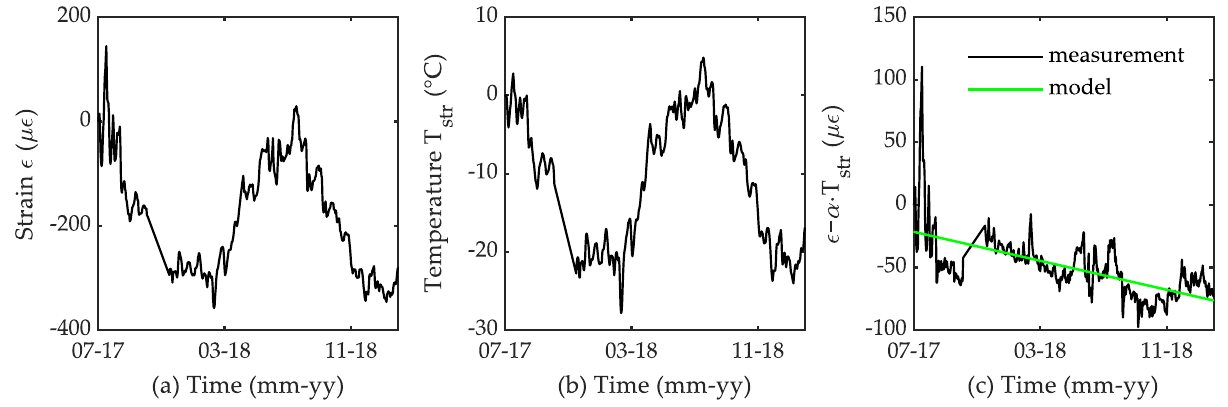
Figure 8. ( a ) 600 days of strain measurements from sensor FBG-2.10-N; ( b ) mean values of 600 days of temperature measurements from sensors C5-1-N and C5-2-N; ( c ) temperature-compensated strain measurements and the posterior local-strain linear-trend m · t over 600 days. Measurements of each sensor are plotted subtracting the first value.